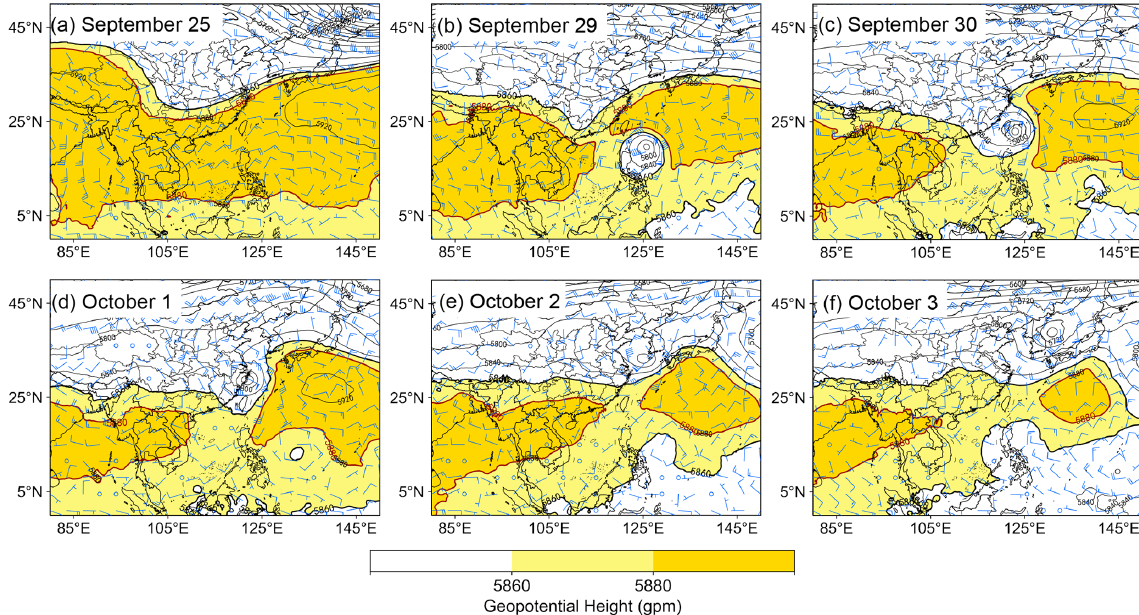
Figure 4. Spatial distribution of 500hPa geopotential height and 850hPa wind fields over East Asia at 14:00 on 25 September (a) and from 29 September to 3 October (b–f)